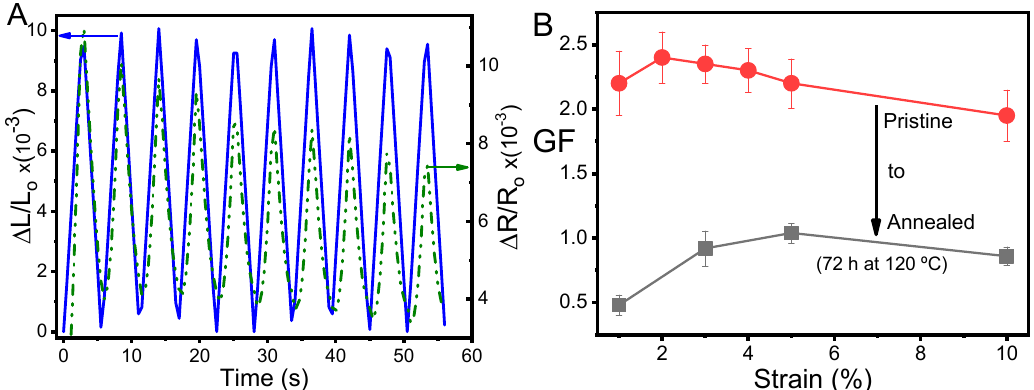
Figure 9. Electromechanical performance of pristine and annealed (72 h at 120 ◦ C) 5CNT / SEBS composite. ( A ) Electromechanical behavior for 1% strain at 3 mm / min for 10 loading–unloading cycles; ( B ) Electromechanical sensibility of the pristine and annealed sensing materials measured at 3 mm / min from 1% to 10% strain. GF: gauge